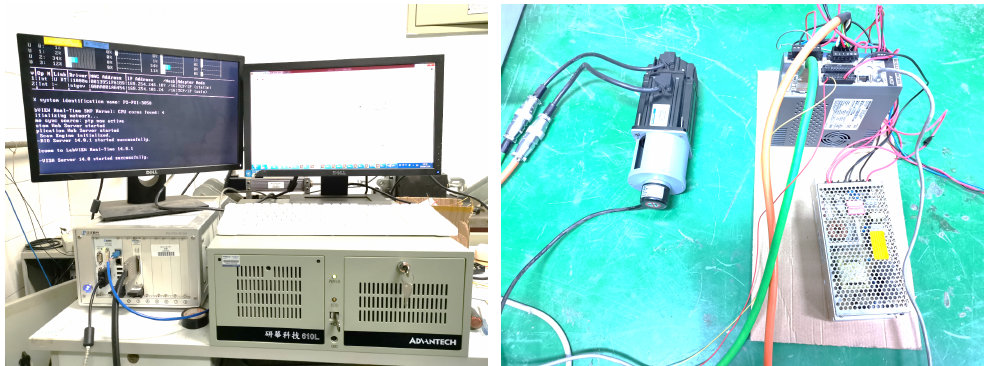
Figure 15. PMSM experimental